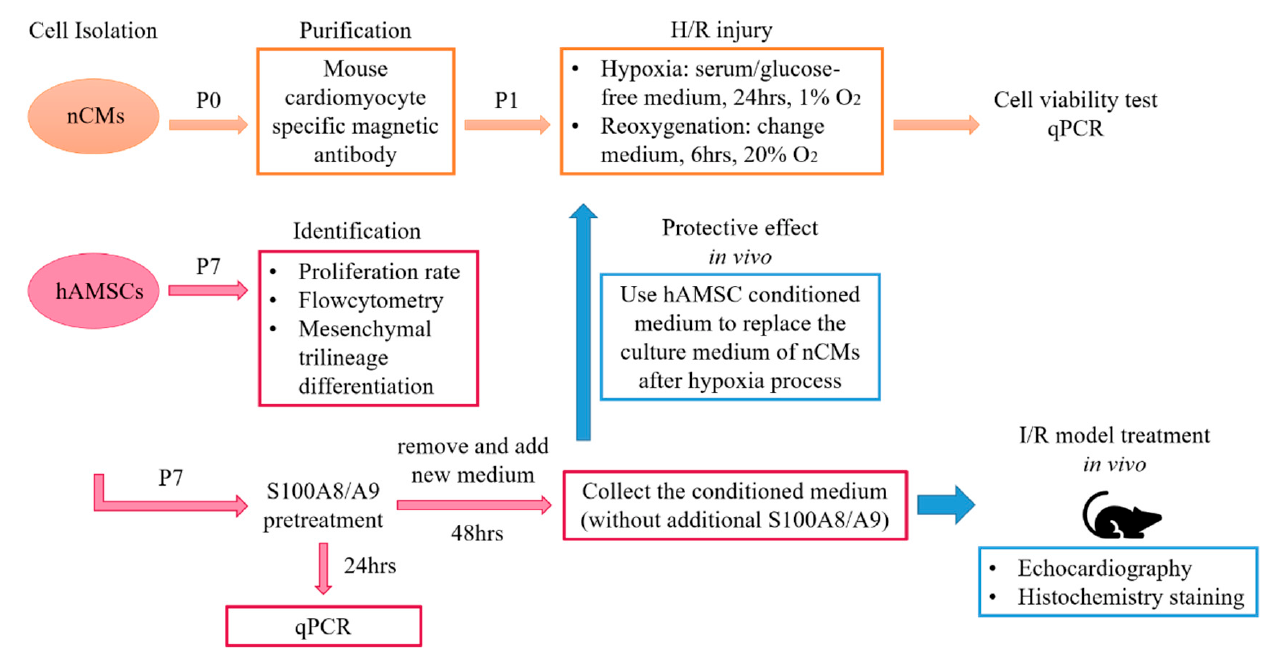
Figure 1. The study flowchart.